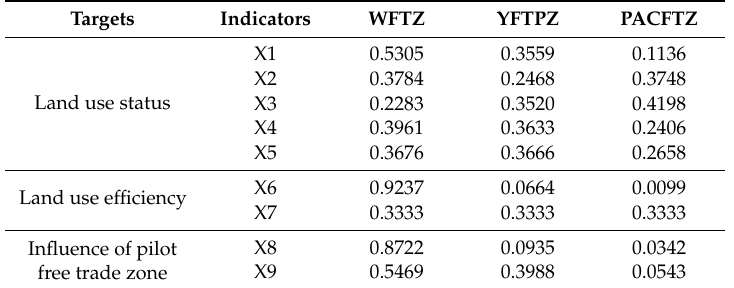
Table 4. Standardized